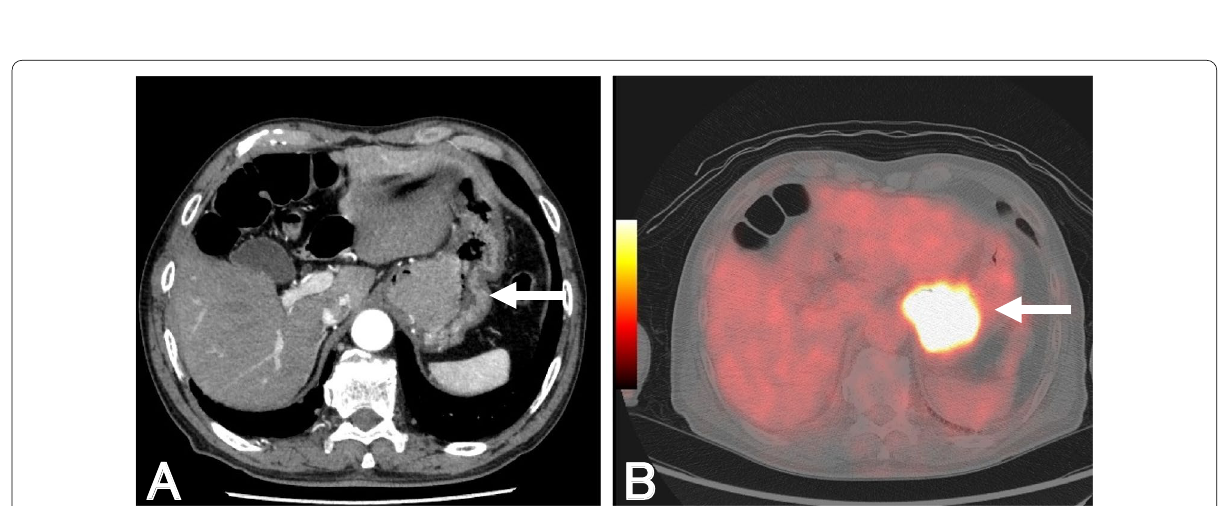
(cid:16109)(cid:16109) (cid:16110)(cid:16110) Fig. 3 Image findings. A Computed tomography. Computed tomography reveals a mass, 50 mm in diameter, in the EGJ (arrow). B 18 F-FDG-positron emission tomography. In 18F-FDG-positron emission tomography, SUV max of FDG accumulation is 19.9 in the tumor